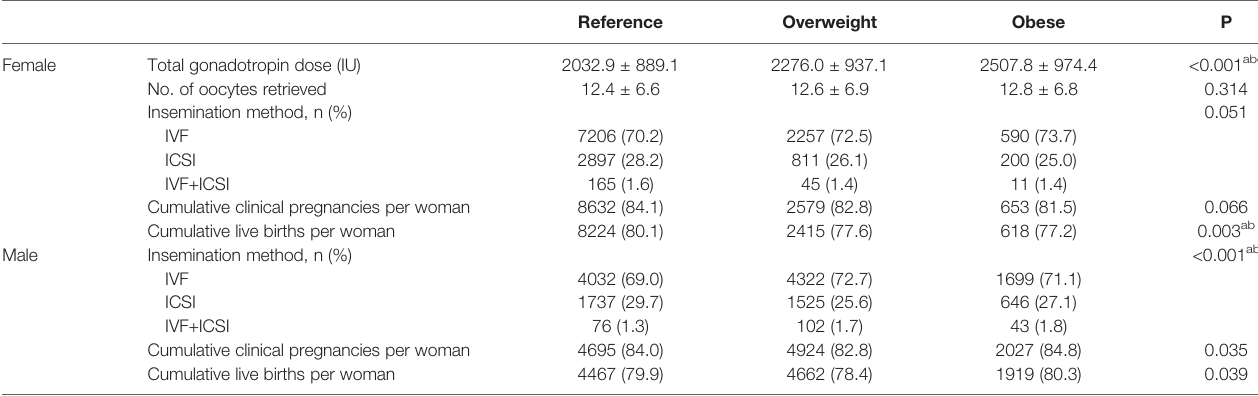
TABLE 2 | Treatment and pregnancy outcomes according to sex and body mass index.